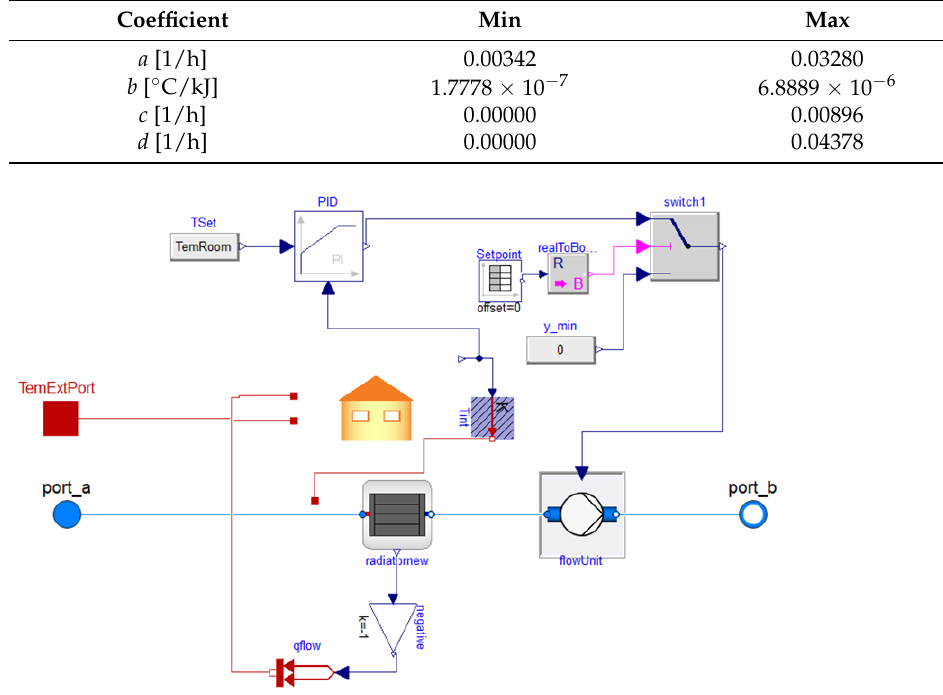
Figure 5. Diagram view of “DemandRC” model component in Dymola.